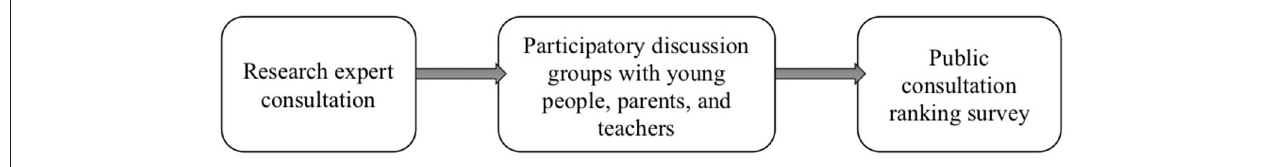
FIGURE 1 | Flow chart presenting the three-stage process of consultation and